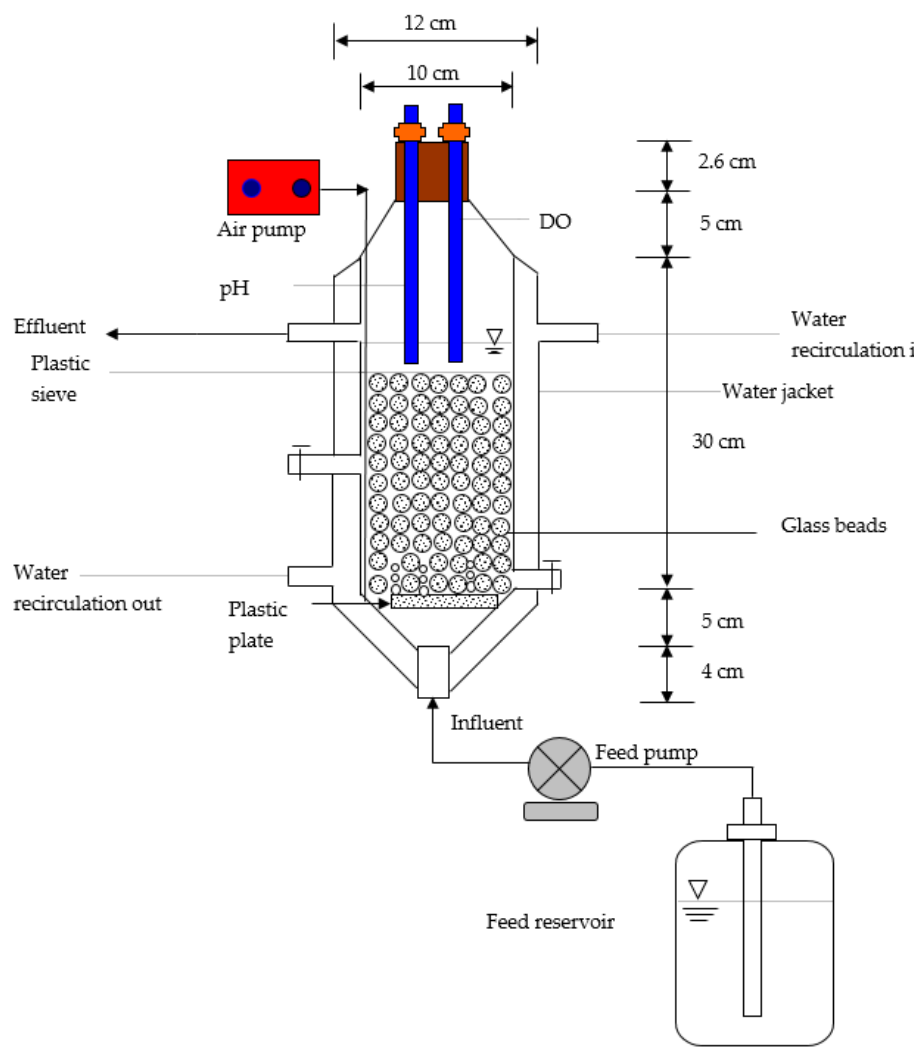
Figure 2. A completely mixed and continuous-flow packed bed bioreactor.